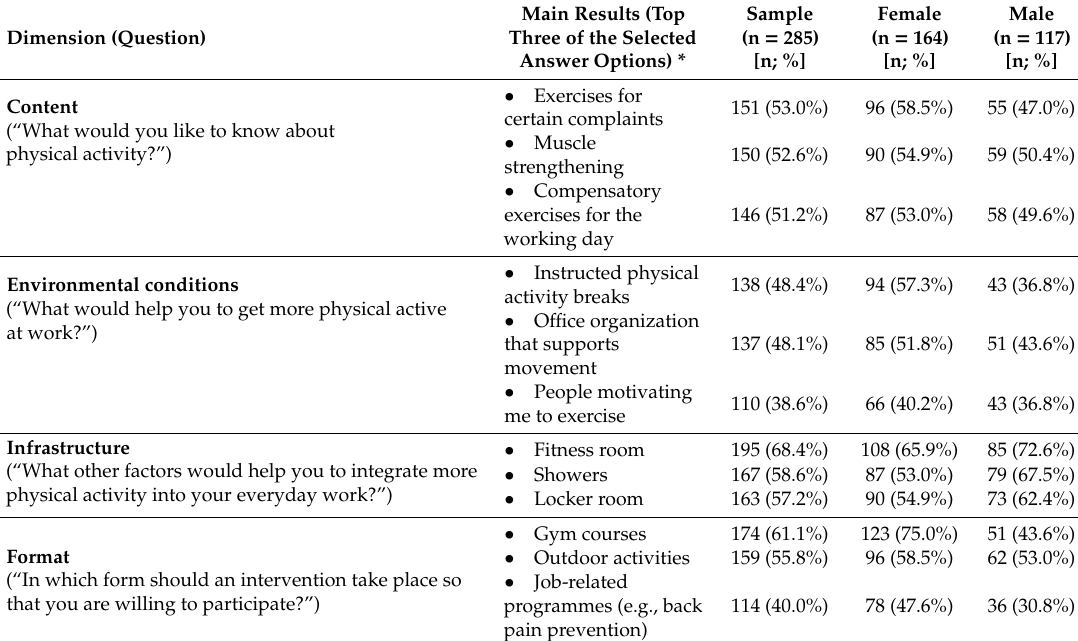
Table 5. Requests with regard to physical activity-related measures